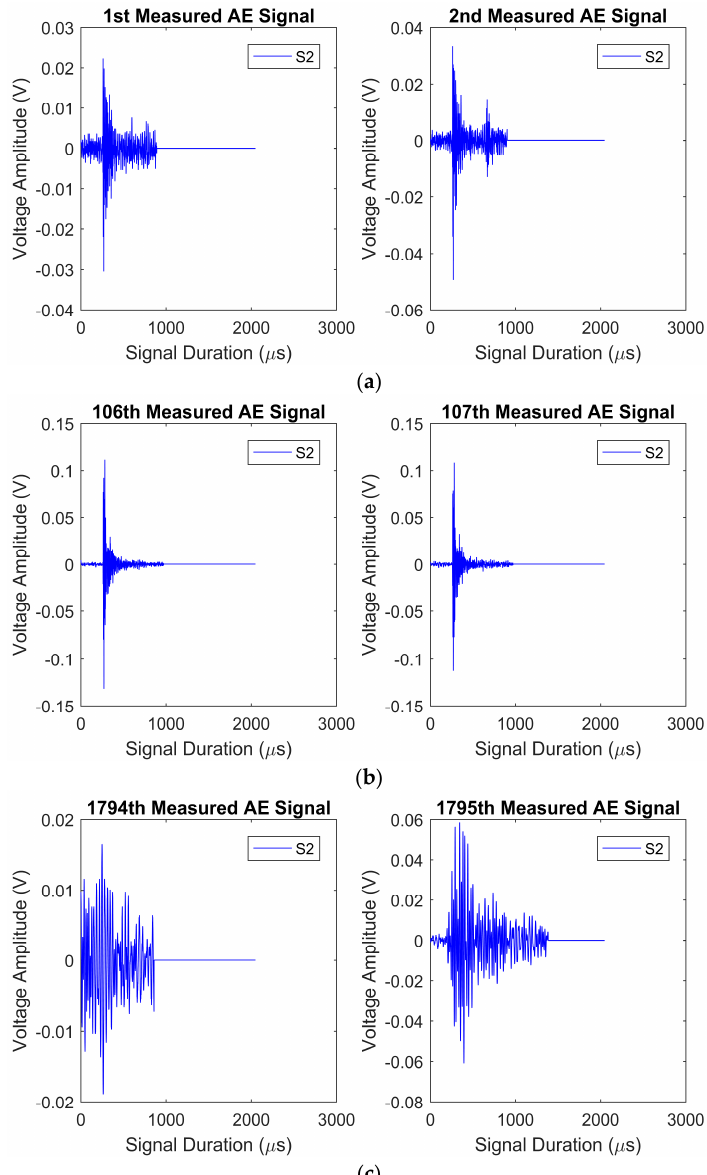
Figure 3. Representative AE waveforms at various instances during the S2 experiment: ( a ) two signals measured in the beginning of the S2 test; ( b ) two signals measured in the instant of crack initiation in the S2 test; and ( c ) two signals measured at instant of complete fracture of the specimen in S2 test. There are two general steps for estimating information entropy from AE signals regardless of the method. A probability distribution of the random variable describing the AE signals must first be